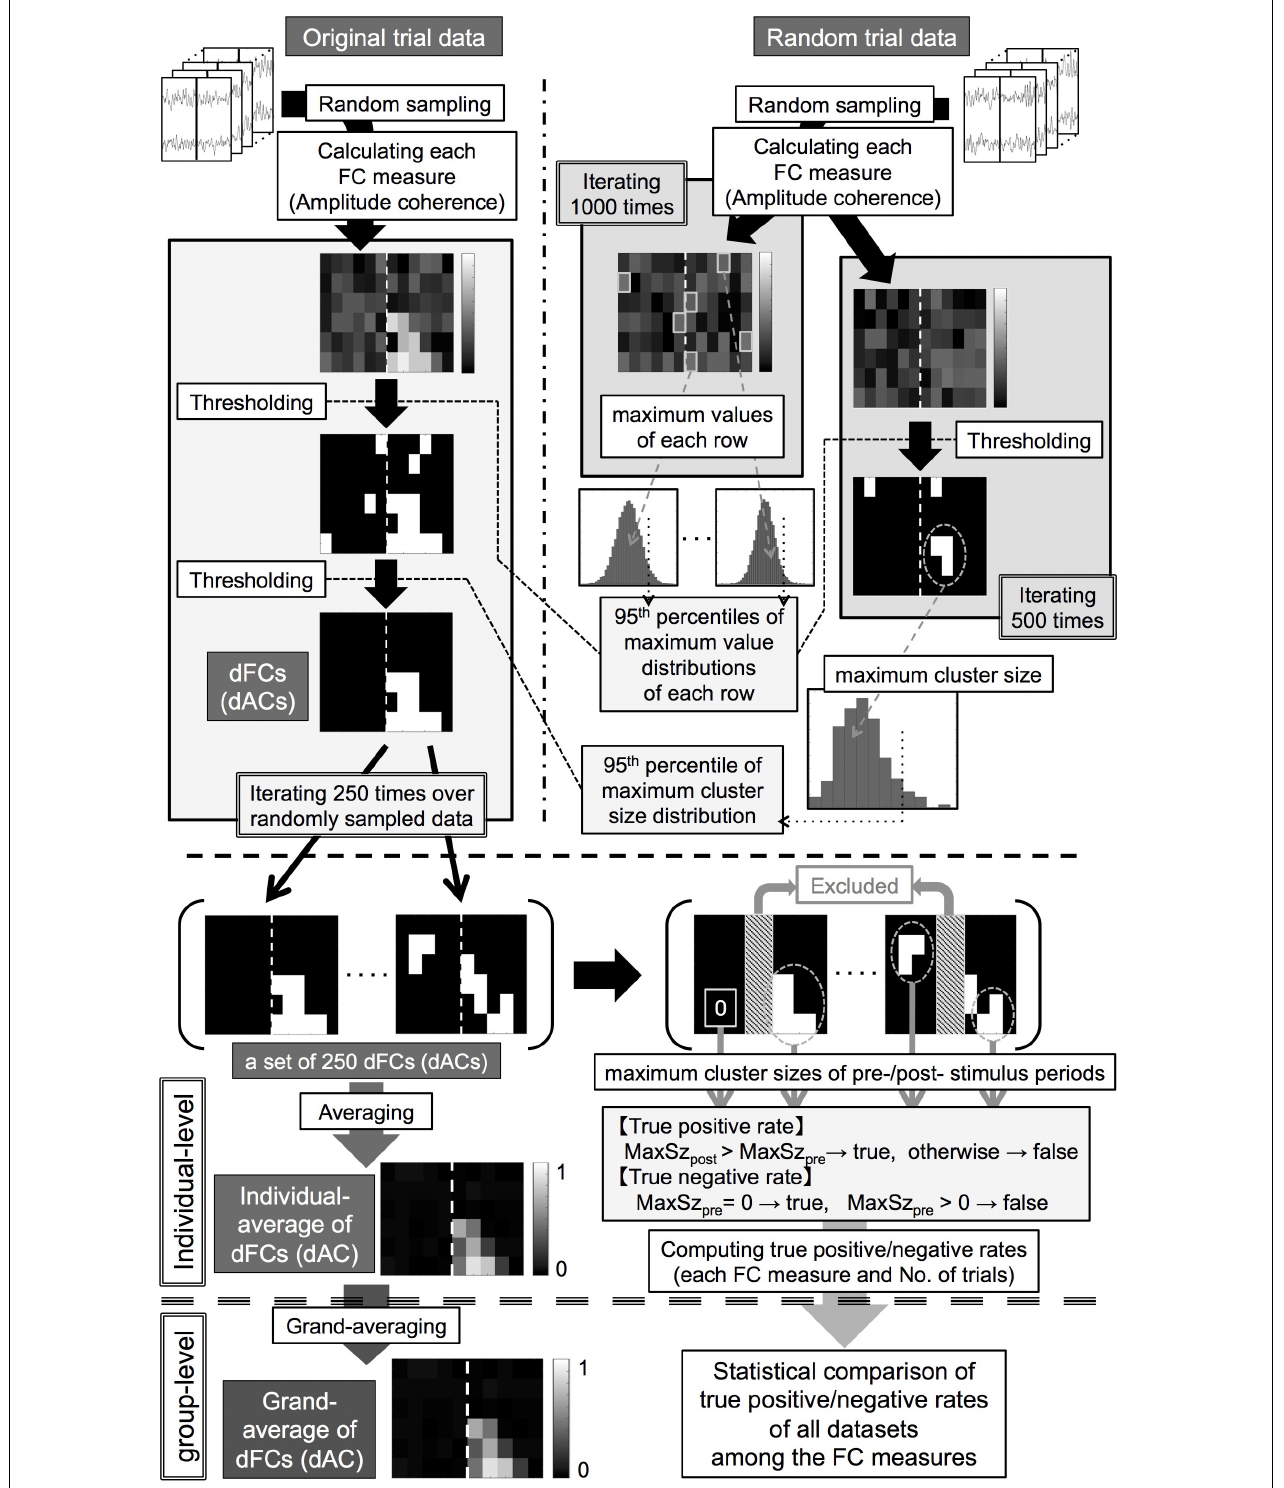
FIGURE 2 | (Upper panel, thick dashed line) Processing pipeline of statistical analysis for identifying significant functional connectivities (FCs) and amplitude coherences (ACs). (Middle panel, thick dashed line) Processing pipeline for an individual-level analysis for obtaining the individual-averages of double-thresholded functional connectivities and true positive/negative rates. (Lower panel, thick dashed line) Processing pipeline for a group-level analysis for the individual results. dFCs/dACs: double-thresholded FCs/ACs, MaxSz pre /MaxSz post : maximum cluster sizes of the prestimulus/poststimulus periods.